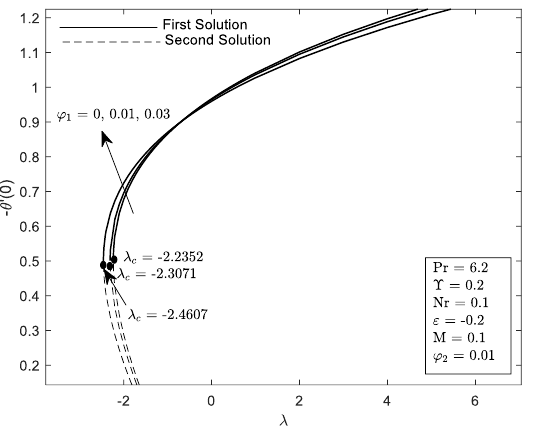
Figure 9. Variation of −𝜃 ′ (0) with mixed convection parameter, 𝜆 for several values of 𝜑 1 .